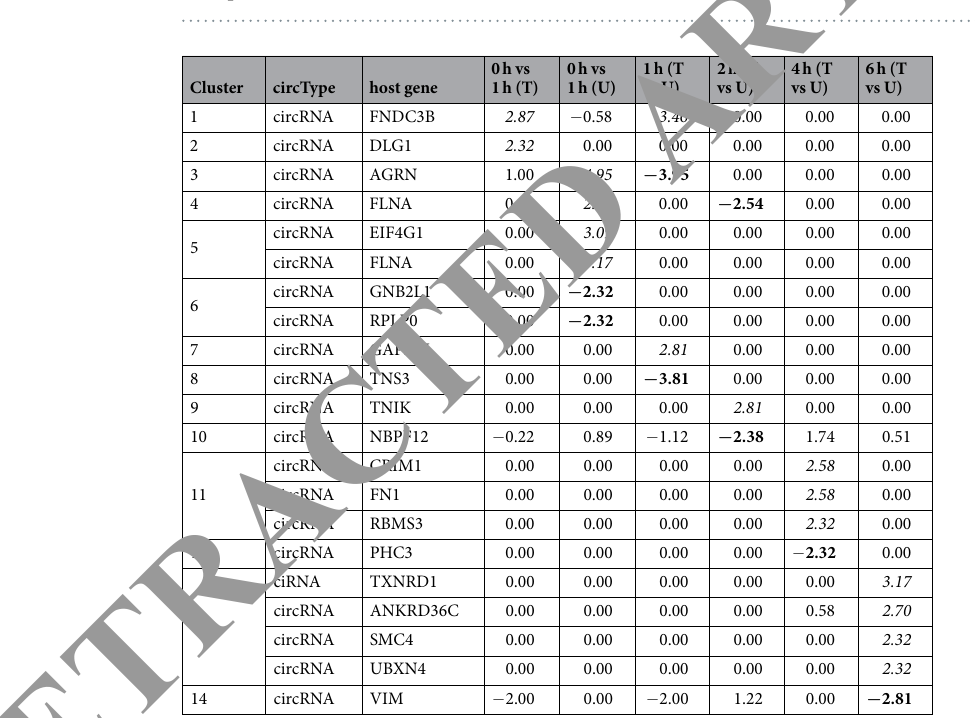
Figure 3. Heat map with piRNA FCs through selected time points. The heat map correlates most altered piRNAs with their own FC (log2 transformed), in a range starting from down–regulated piRNAs (green) to up– regulated ones (red). It is highlighted that down–regulated represent the prevalent altered piRNAs in all selected time points.